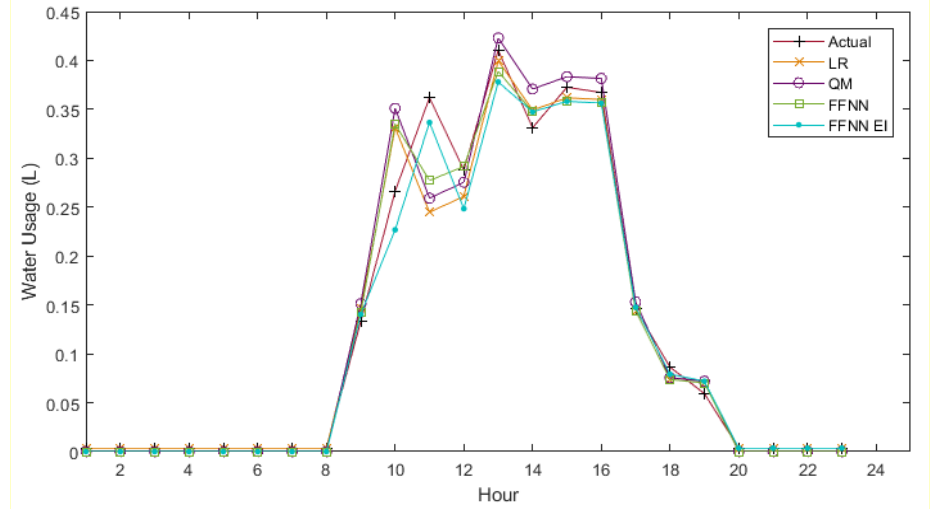
Figure 5. Day-ahead forecasts for tomatoes.